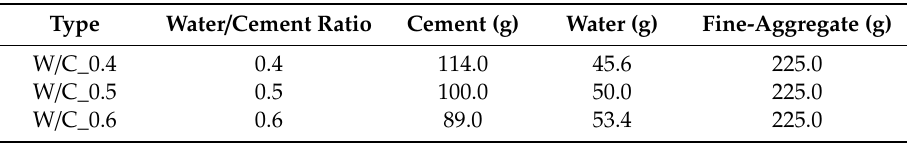
Table 1. Specimen parameters utilized in